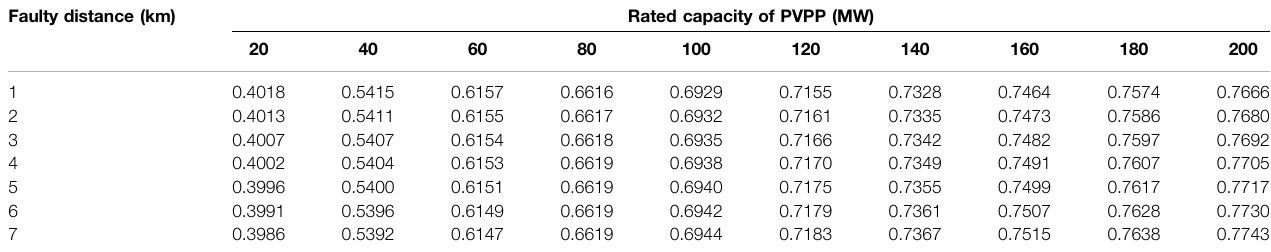
TABLE 1 | The operate impedance amplitude with different rated capacity and various fault locations. Faulty distance